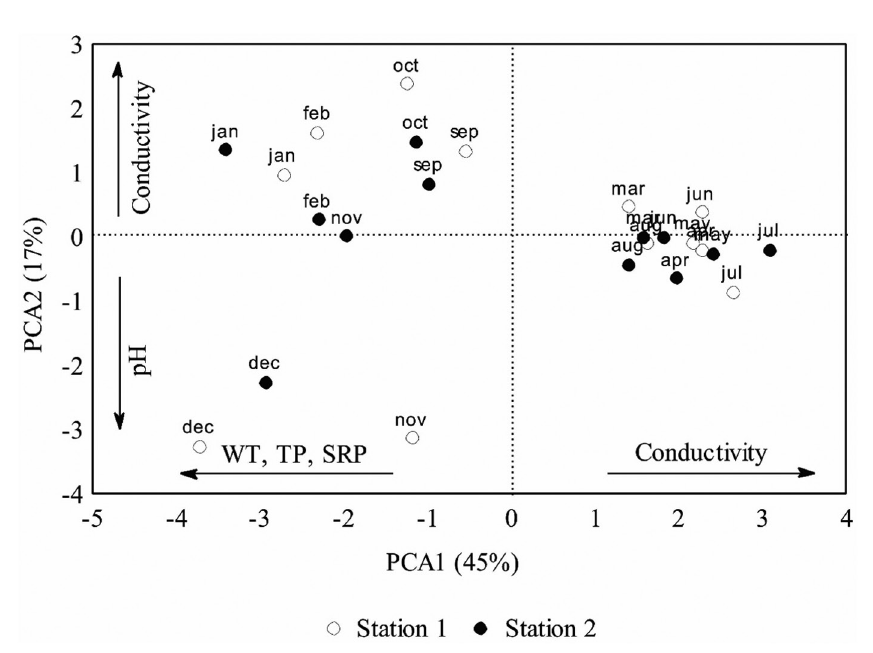
Figure 2. Dispersion of the scores of the first two axes of the Principal Component Analysis performed using the abiotic variables in the stabilization ponds (Conductivity – electrical conductivity; SRP – soluble reactive phosphorus; TP – total phosphorus; WT – water temperature; pH; jan – January; feb – February; mar – March; apr – April;